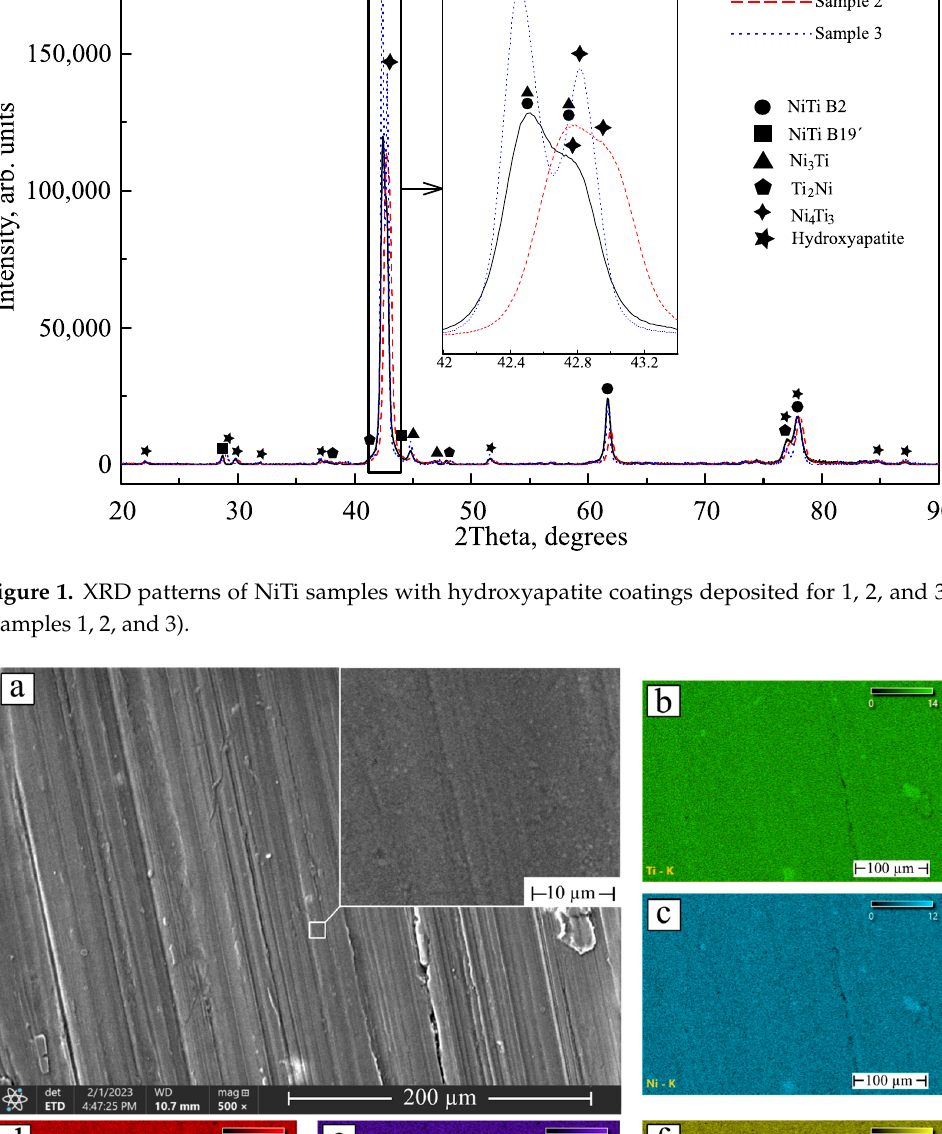
Figure 3. ( a ) SEM image of the NiTi with hydroxyapatite coating deposited for 2 h and elemental maps of: ( b ) Ti; ( c ) Ni; ( d ) Ca; ( e ) P; and ( f ) O. The coating on sample 3 was characterized by a uniform dense surface morphology over the entire area without visible defects, cracks, or chips as seen in Figure 4 in contrast to the coatings on samples 1 and 2.